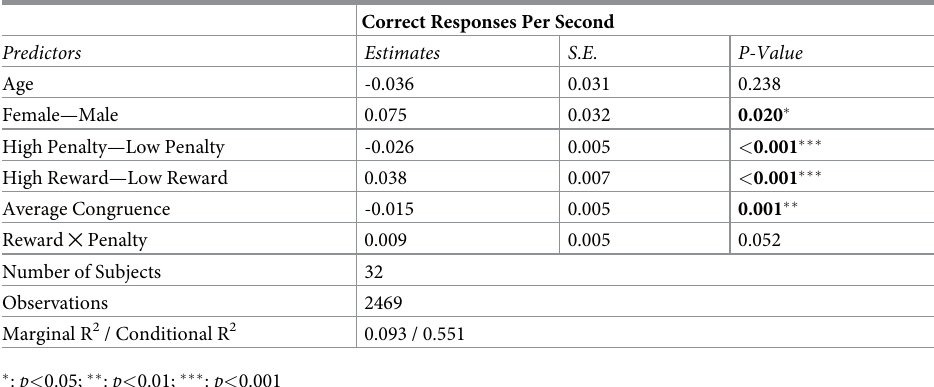
Table 1. Mixed Model Results for Correct Responses per Second (Study 1).